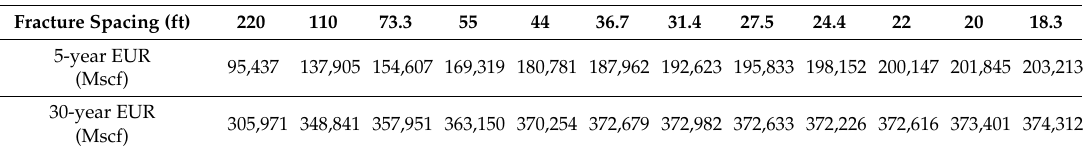
Table 5. Variation of 5-year and 30-year EURs (Mscf) when producing with fracture spacing varying between 220 and 18.3 ft, as forecasted by the flow-cell